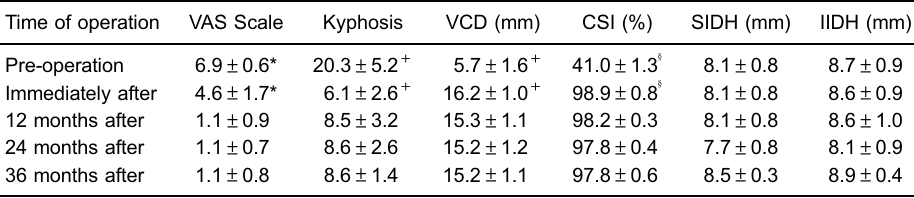
VAS: visual analog scale; VCD: vertebral canal dimension; CSI: canal stenosis index; SIDH: superior intervertebral disc height; IIDH: inferior intervertebral disc height. *P o 0.05, immediately after compared to